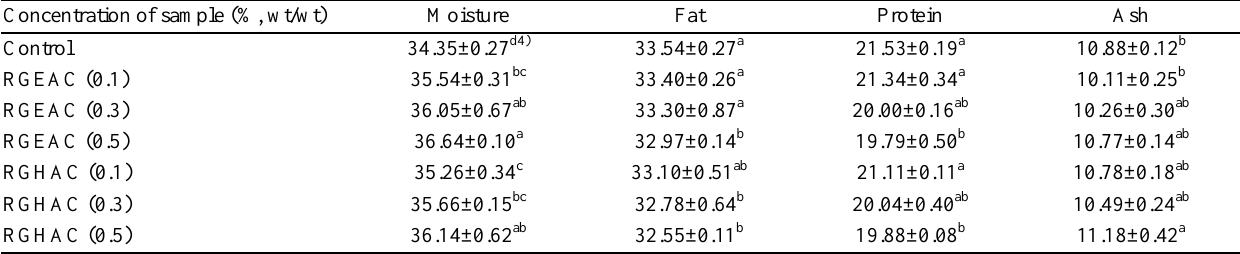
Control, Asiago cheese; RGEAC, red ginseng extract-added Asiago cheese; RGHAC, red ginseng hydrolyzate-added Asiago cheese; SD, standard deviation.